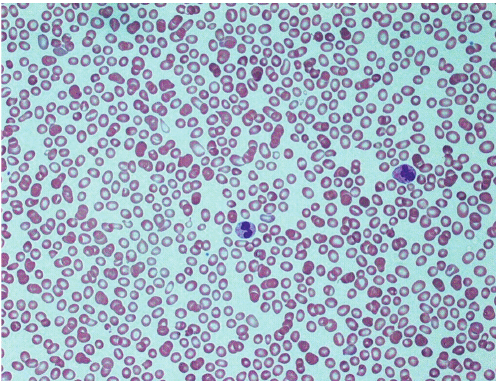
Figure 1: Mild red cell anisocytosis with macrocytosis and mod- erate numbers of tear drops. Mild granulocyte left shift and dys- plastic changes (hyposegmented and hypersegmented neutrophils). Peripheral blood film. Wrights stain × 200 .